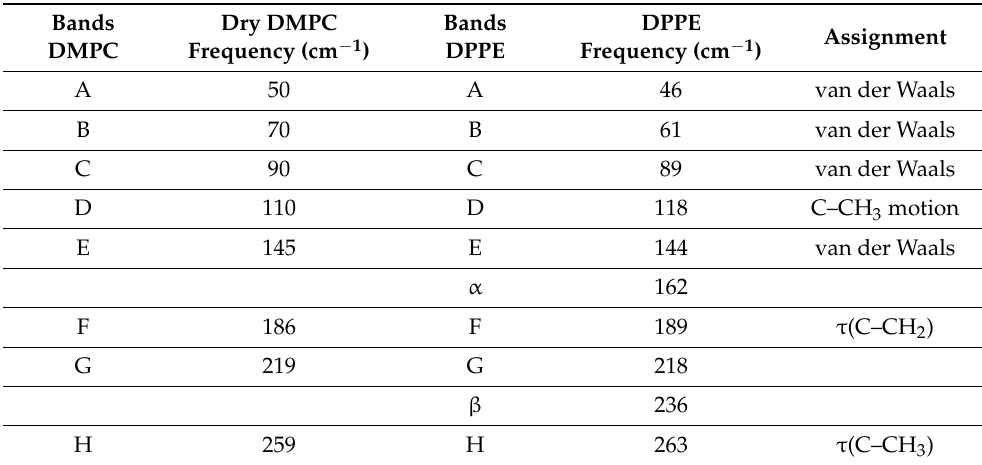
Table 2. Frequencies and tentative assignments of the bands identified in this work for both DPPE and DMPC samples.